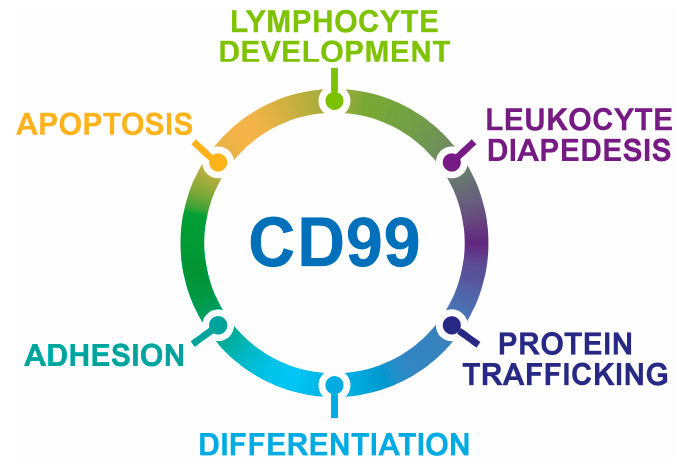
Figure 1. Schematic representation of the biological processes regulated by CD99.